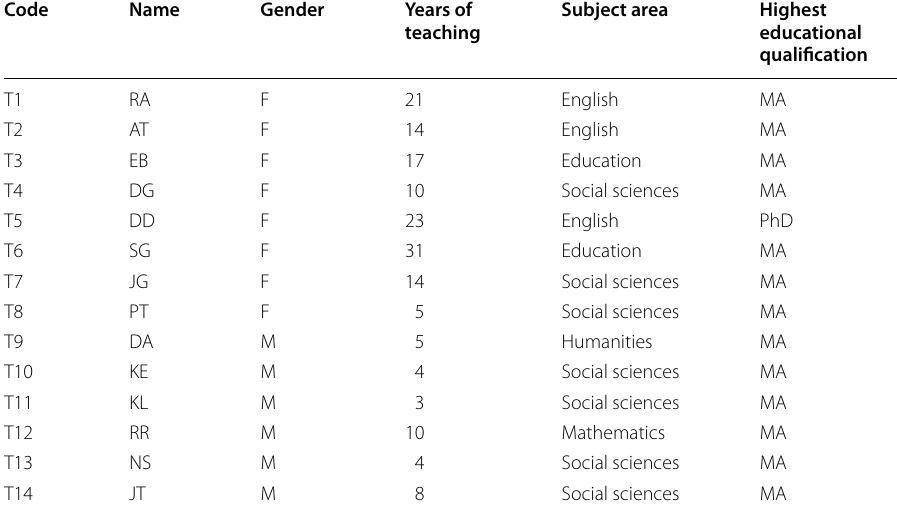
Table 1 Teachers’